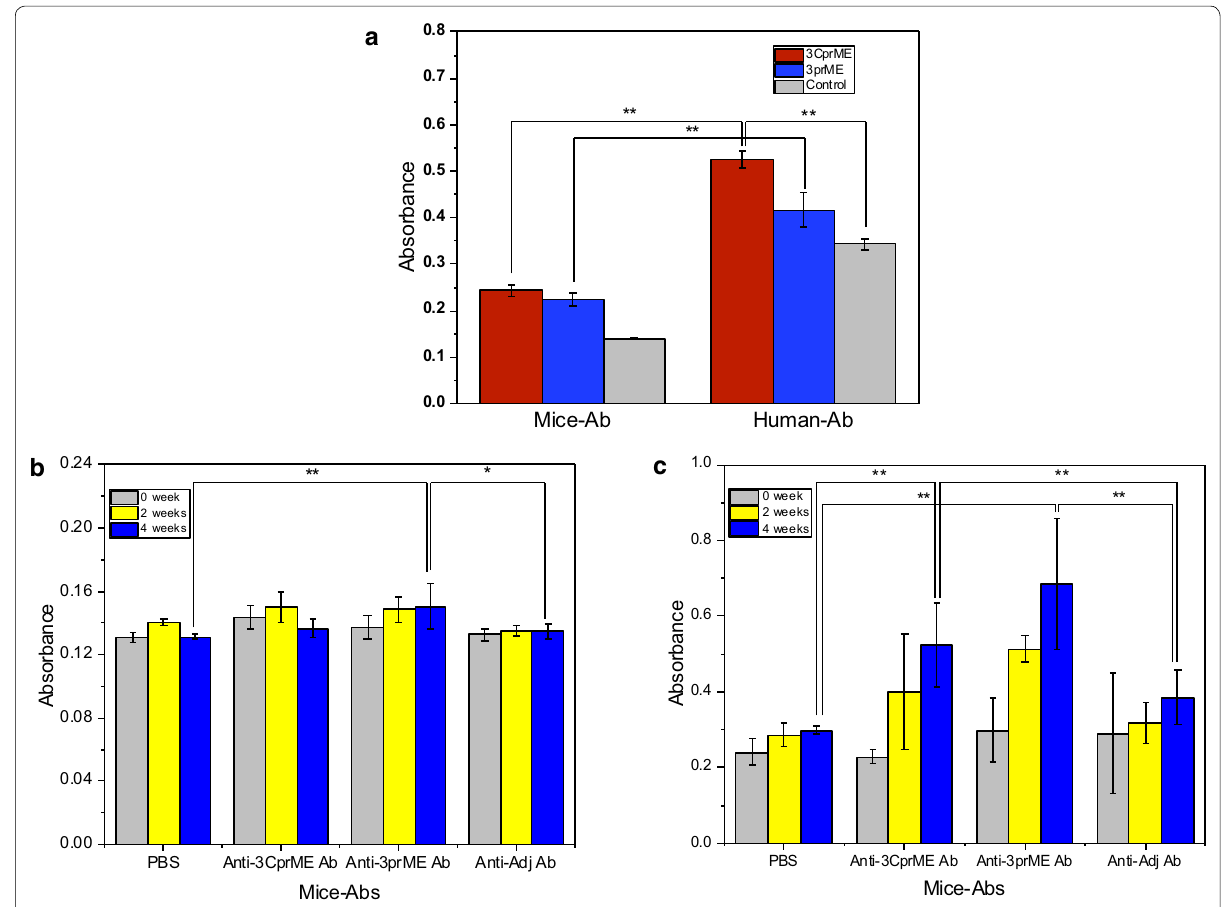
Fig. 6 a The interactions between DENV-LPs/3CprME and /3prME with sera from mice immunized with the DENV tetravalent DNA vaccine and mixed sera from dengue patients [NS1( ), RT-PCR ( )] were investigated. Binding reactions were analyzed using direct ELISA as described (Welch + + t-test, **p < 0.01). Specific IgG generation by DENV-LPs/3CprME ( b ) and /3prME ( c ). BALB/c mice were intraperitoneally immunized with 50 μg monovalent DENV-LPs/3CprME and/3prME. At 2 and 4 weeks, sera were collected and analyzed for specific IgGs (Welch t-test, *p < 0.05, **p <